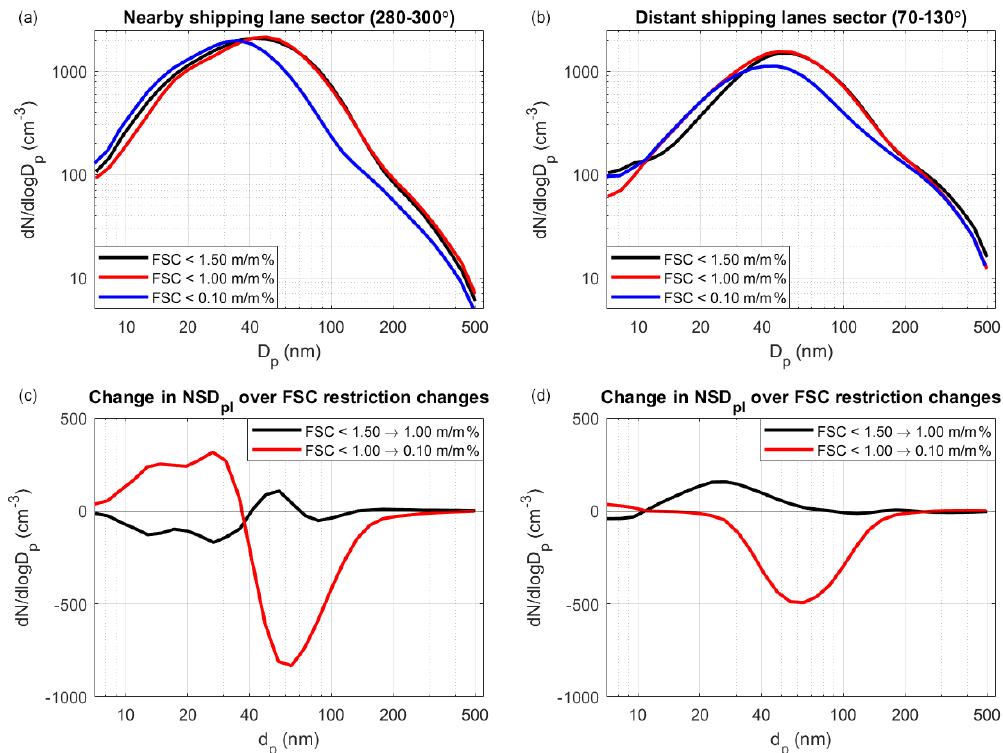
Figure 9. (a) Average number size distribution of the plumes (NSD pl ) from the nearby shipping lanes sector (280–300 ◦ ) and (b) from the distant shipping lanes sector (70–130 ◦ ) during the three fuel sulfur content (FSC) restriction periods. (c) Change in NSD pl in the nearby